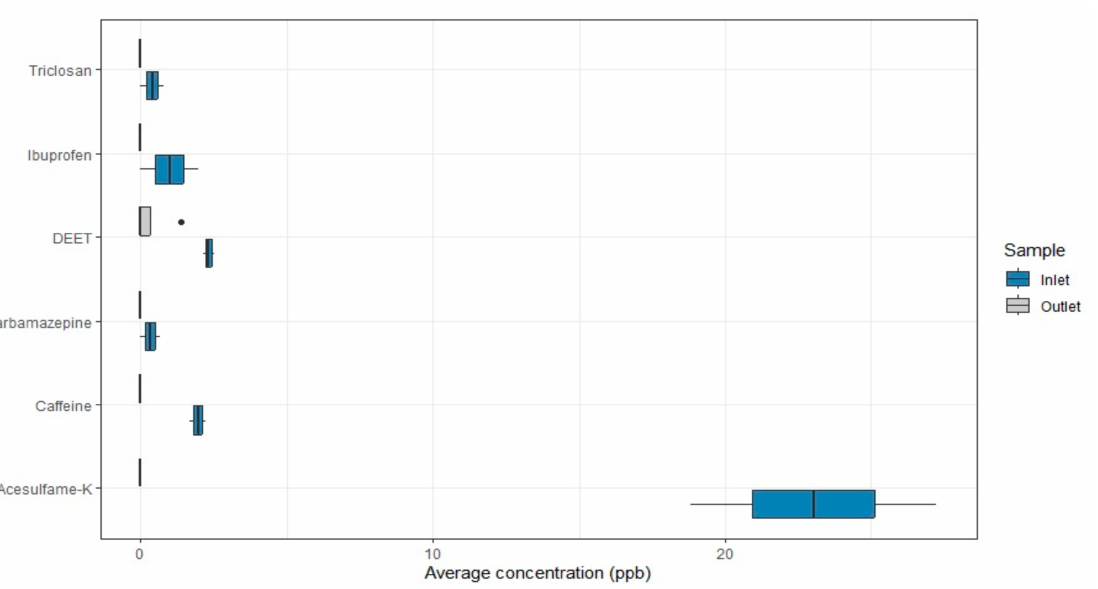
(0.33 ± 0.47 ppb), caffeine (1.96 ± 0.39 ppb), and acesulfame-K (23.03 ± 5.96 ppb) (Figure